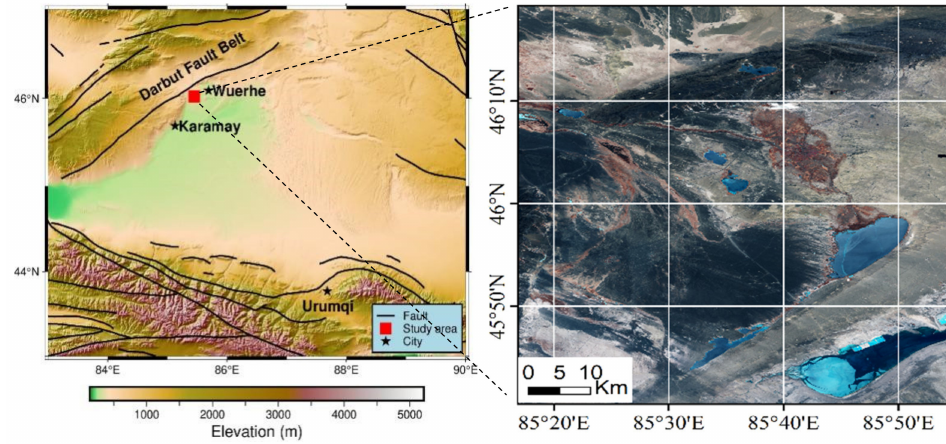
Figure 1. Study area map. ( left ) Tectonic background map. ( right ) Regional remote sensing